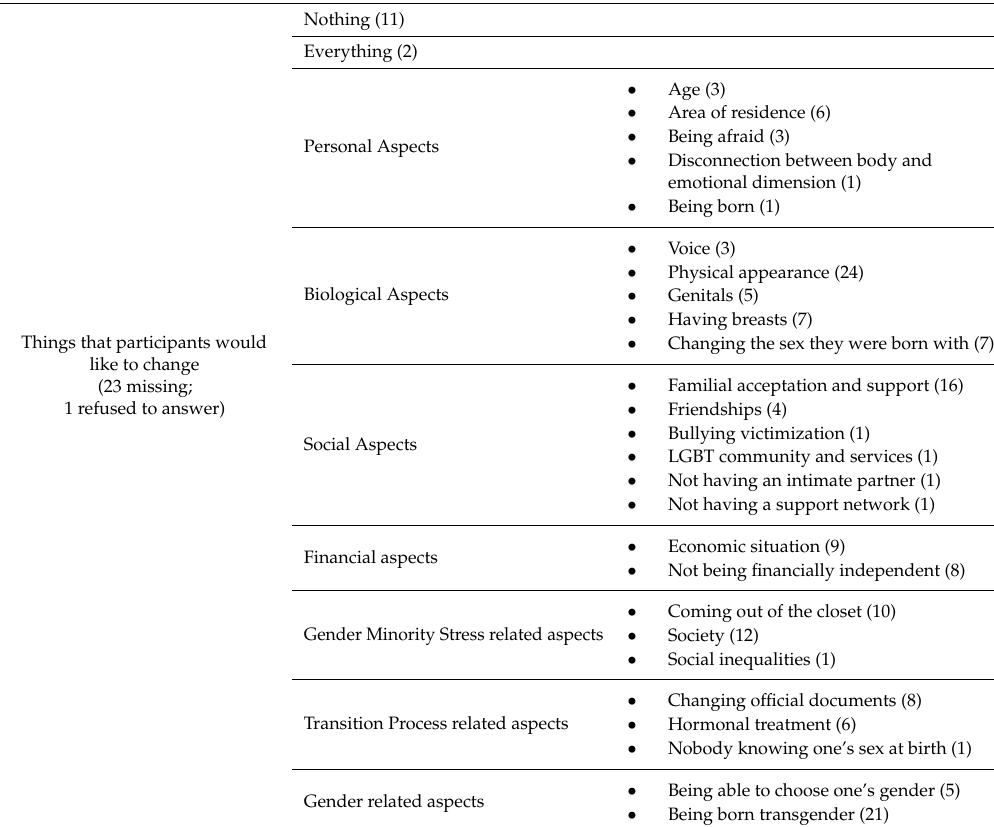
Table 5. Main themes and respective codes regarding the question “In your own words, if you were capable of changing something right now, what would it be and